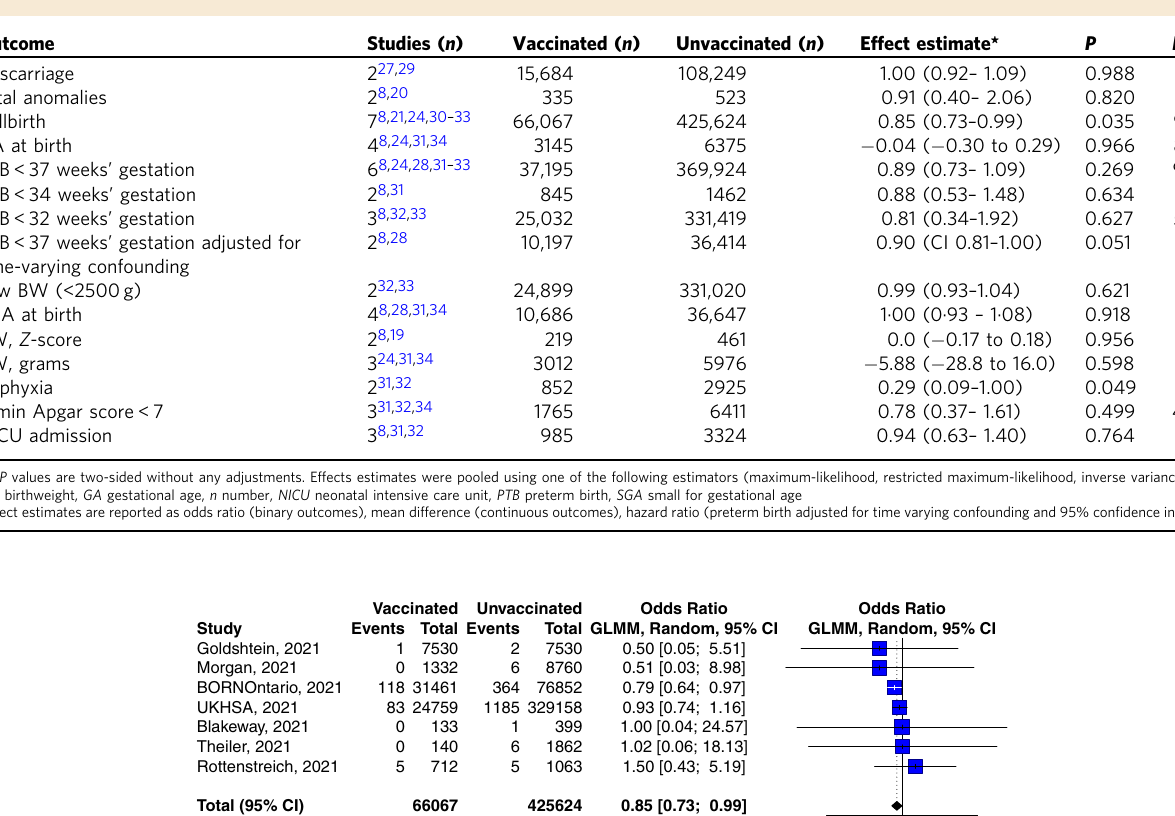
Table 2 Meta-analysis of maternal and perinatal outcomes in studies comparing COVID-19 vaccinated and unvaccinated pregnancies.